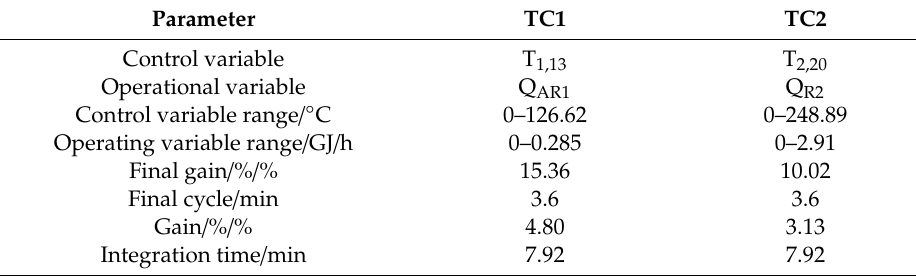
Figure 10. Control structure CS1, control panels, and flowsheet equations for the partial HIPSD process. Table 6. Tuning parameters of temperature controllers TC1 and TC2.